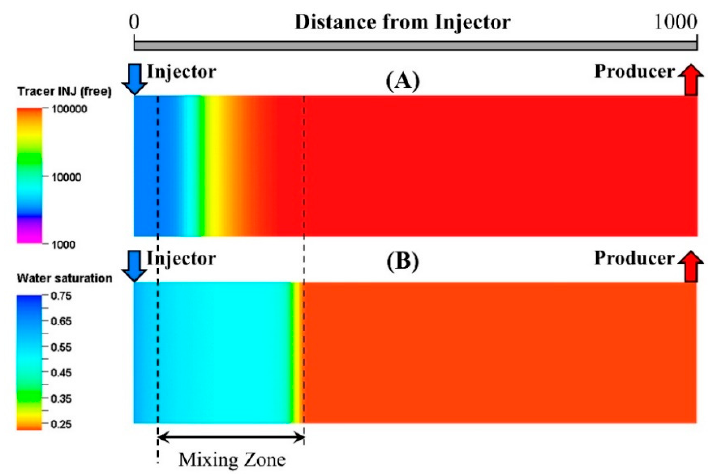
Figure 2. Numerical simulation results of the 1D model of water displacement illustrating ( A ) the profile of tracer concentration and ( B ) water saturation profile. The waterfront and the mixed zone were highlighted in both profiles.